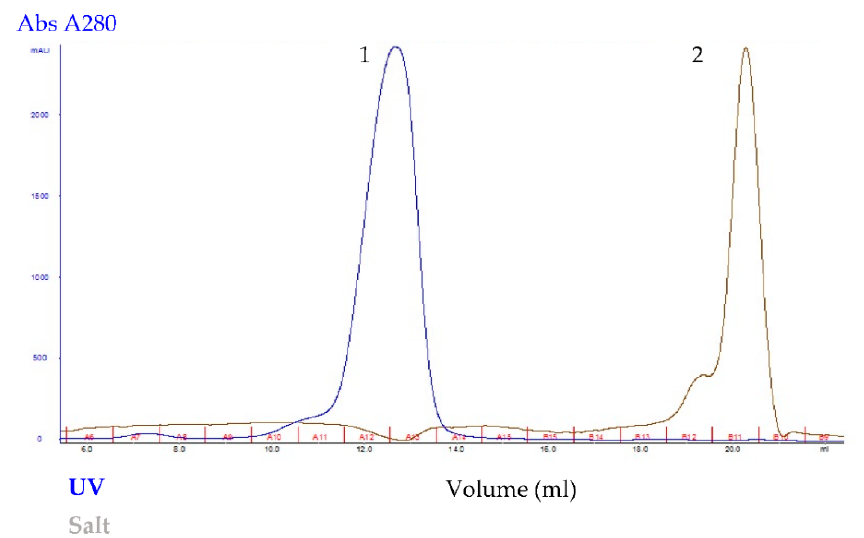
Figure 3. The elution profile of Pk- LDH protein showed by gel filtration using SuperdexTM 200 GL 10/300 column, which exhibited a single peak protein elution (1) (blue trace). Brown trace indicates salt solution (2).